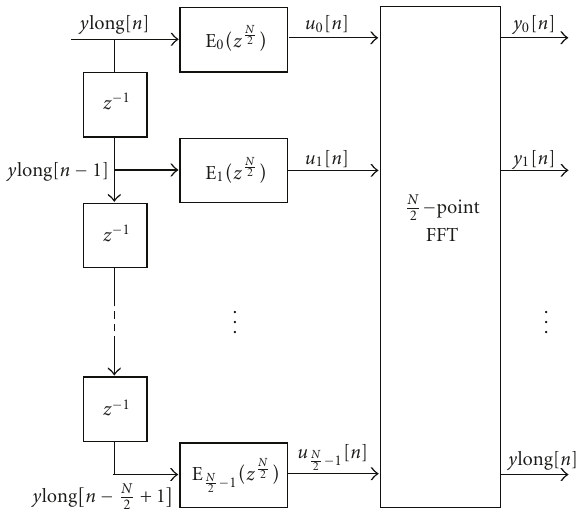
Figure 6: The signal analyzer for timing